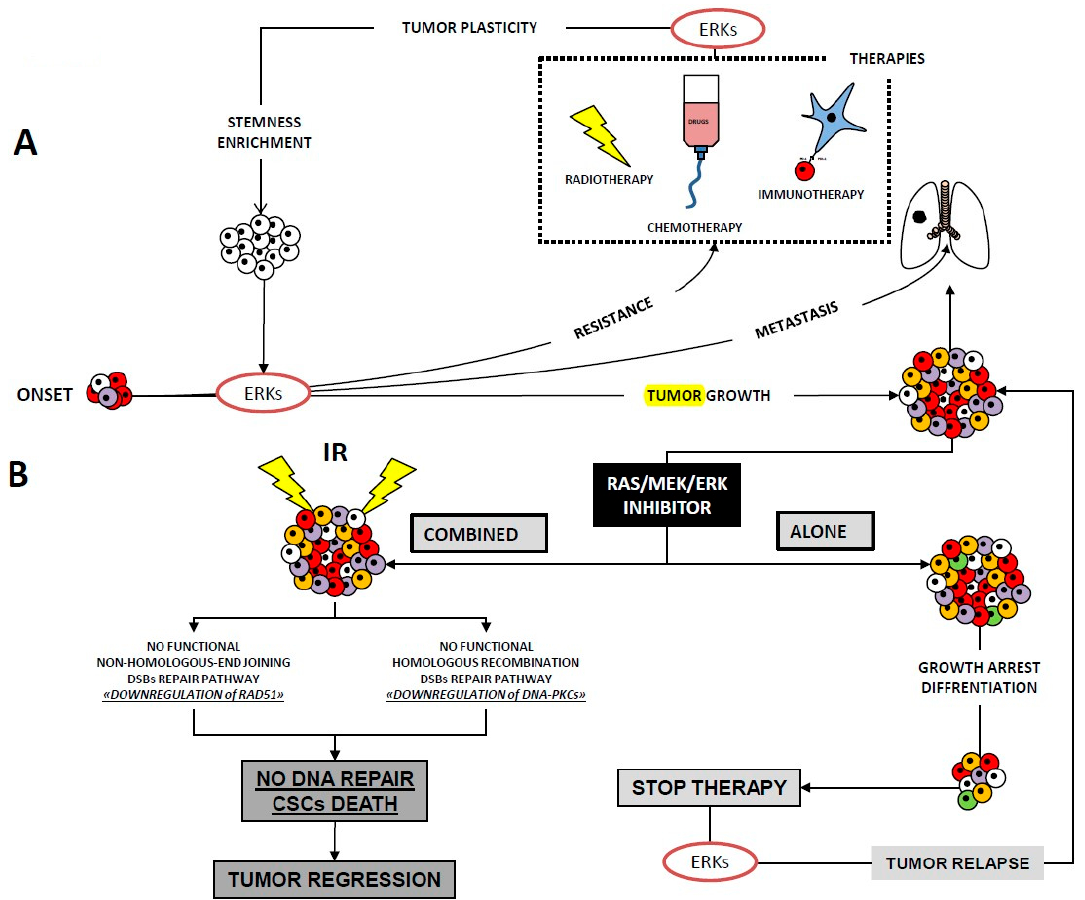
Figure 2. Schematic representation of ERK1/2 signalling leading to multiple tumour responses in: ( A ) onset of tumour growth, resistance to chemo- and radiotherapy (dotted square), metastasis and tumour plasticity due to ERK-induced radiotherapy, chemotherapy or immunotherapy, often leading to selection of cancer stem cell (CSCs); ( B ) RAS/MEK/ERK inhibitor alone has limited benefit whereas followed by irradiation (IR) inhibits the mechanism of DNA repair and favours CSCs death with tumour regression.